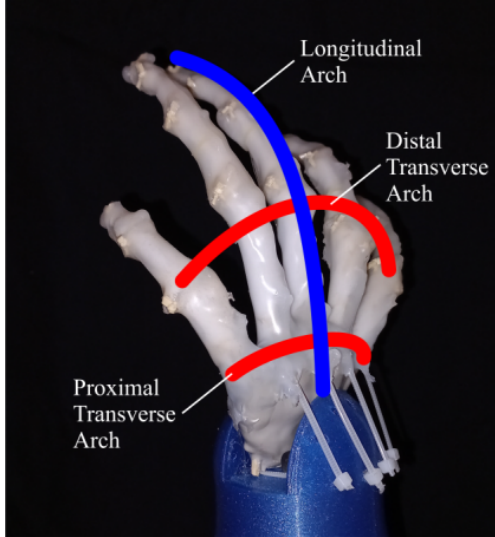
Figure 2. Skeletal arches of the